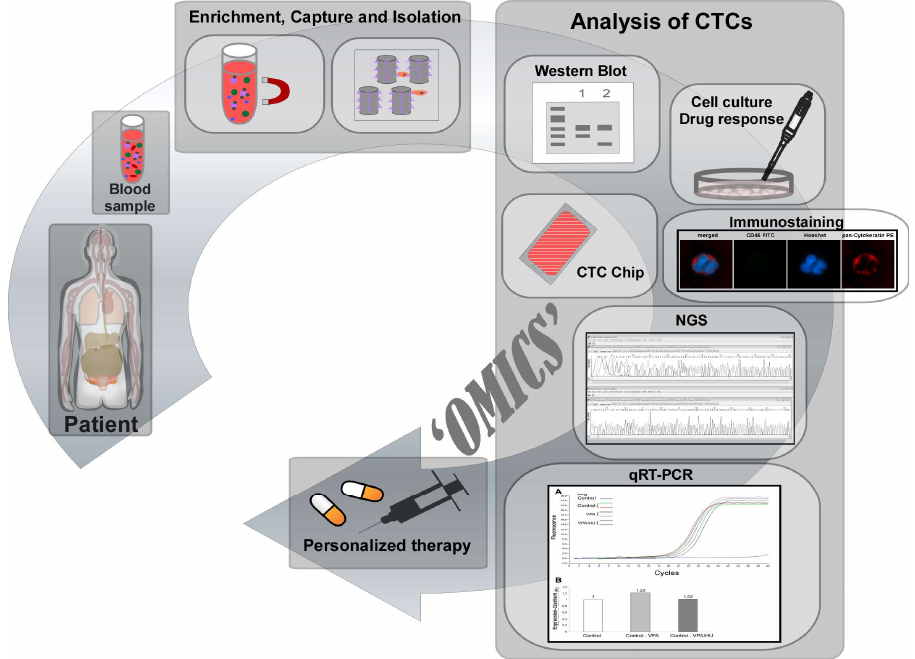
Figure 1. Overview of CTCs analysis of patients-derived CTCs including drug resistance detection and personalized therapy: Patients’ blood sample is screened and potential CTCs are captured and isolated by different isolation methods. Potential CTCs can be determined and used for further analysis to develop personalized medicine.